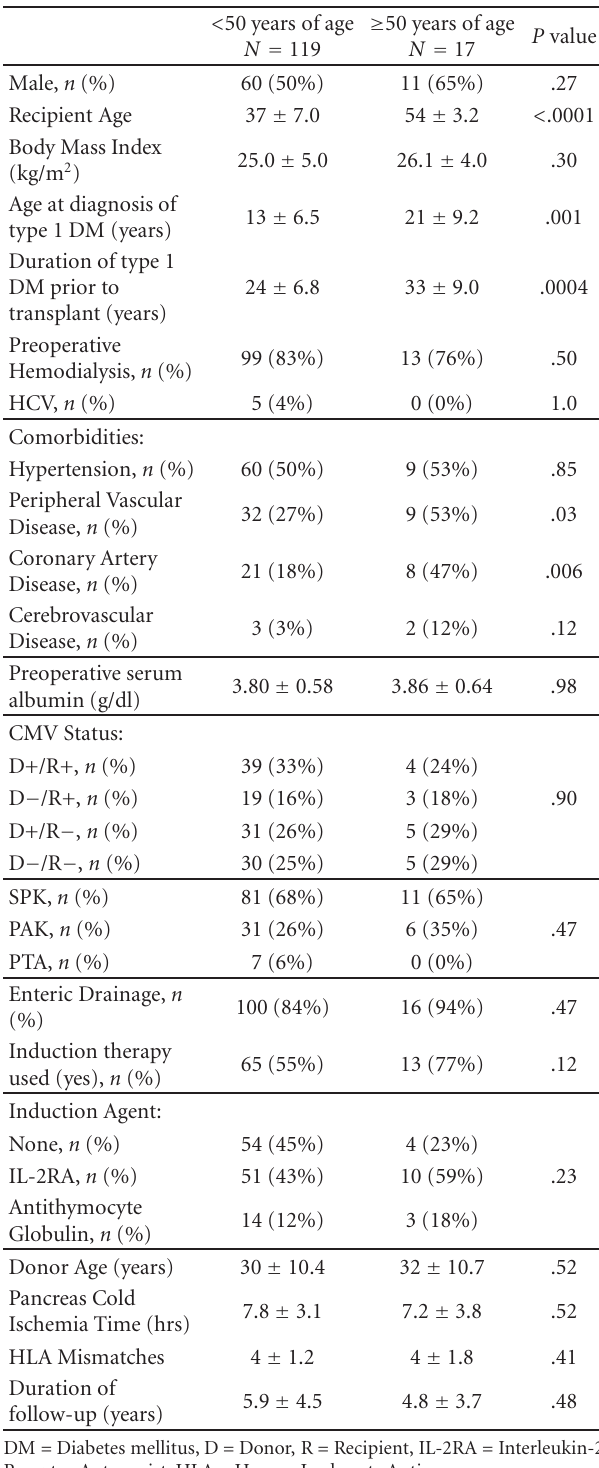
Table 1: Patient characteristics and donor